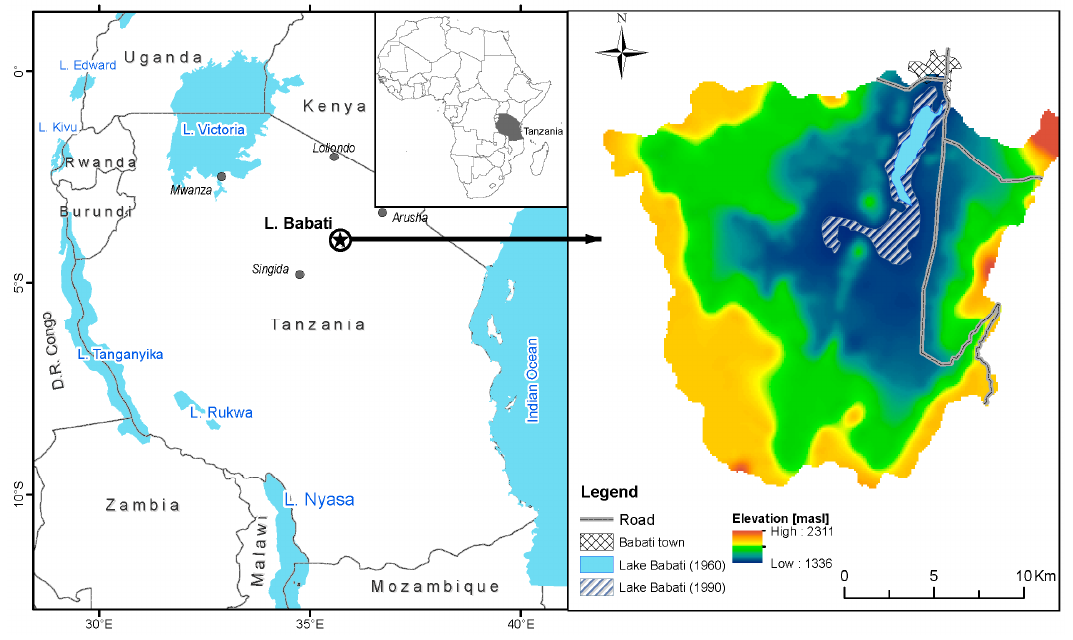
Figure 1. Location of Lake Babati ( left ); and the Lake and its catchment area ( right ).